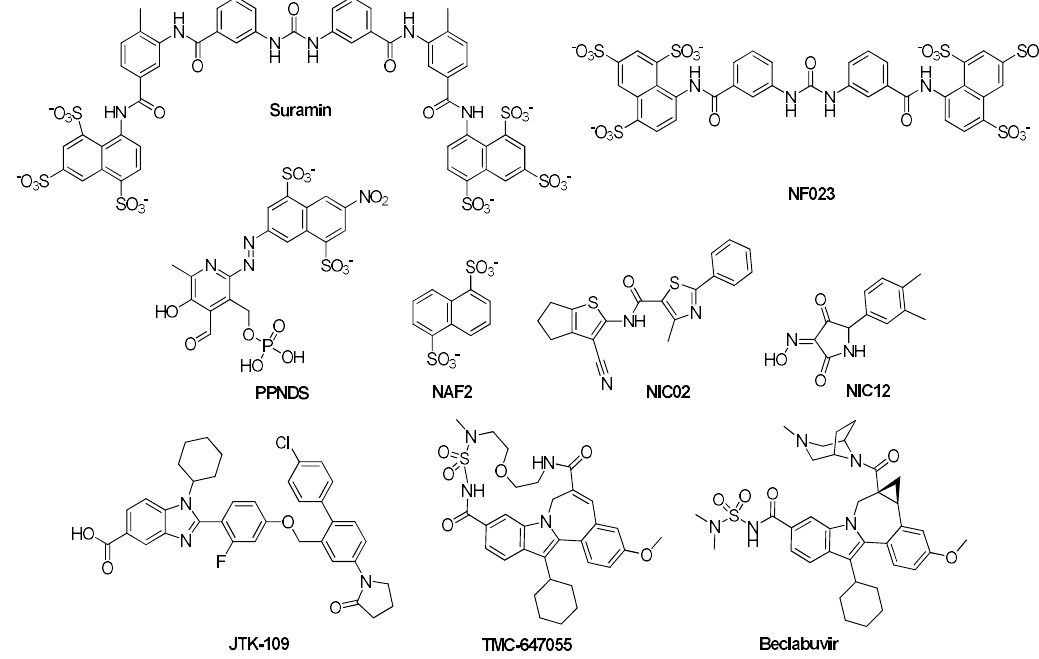
Figure 10. Structures of reported non-nucleoside inhibitors of the Caliciviridae RdRp.